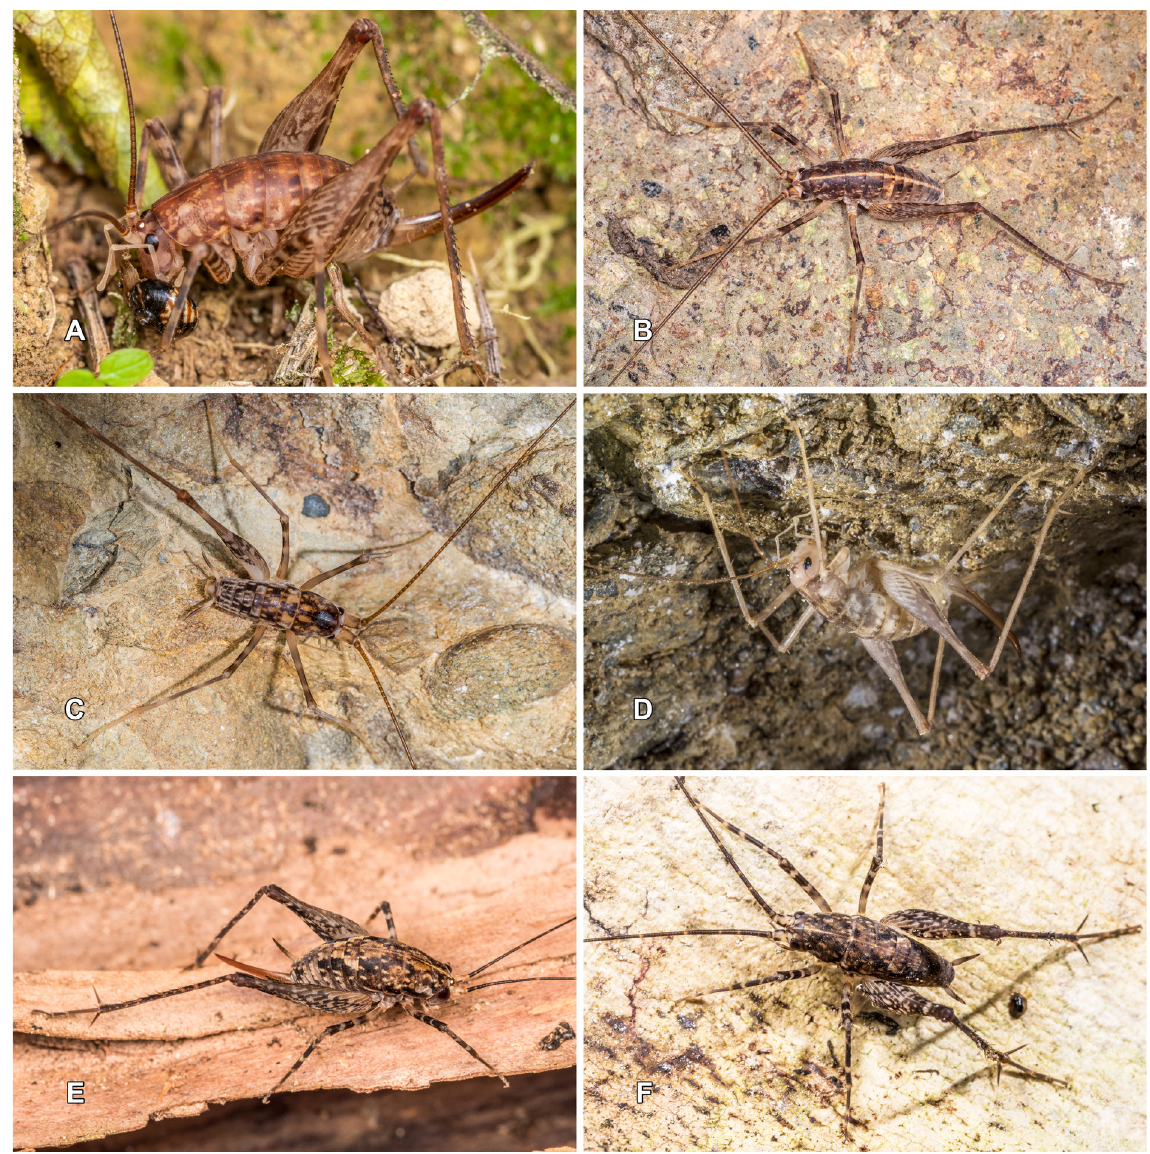
Fig. 14. Live Pleioplectron Hutton, 1896 in their natural environments. A–B . P. simplex Hutton, 1896, Hinewai Reserve, Banks Peninsula. A . Adult ♀ feeding on a small native snail Flammulina zebra (Le Guillou, 1842). B . Adult ♂. The different colouration is due to individual variation, not sexual dimorphism. C–D . P. thomsoni (Chopard, 1923) comb. nov. C . Adult ♂ in natural cave, Trotters Gorge, Otago. D . Adult ♀ in mining tunnel in Bannockburn, Central Otago, where a population of nearly white colour exists. E . P. hudsoni Hutton, 1896, adult ♀, Otaki Forks, Tararua Forest. F . P. triquetrum sp. nov., ♂, Hinau Track,